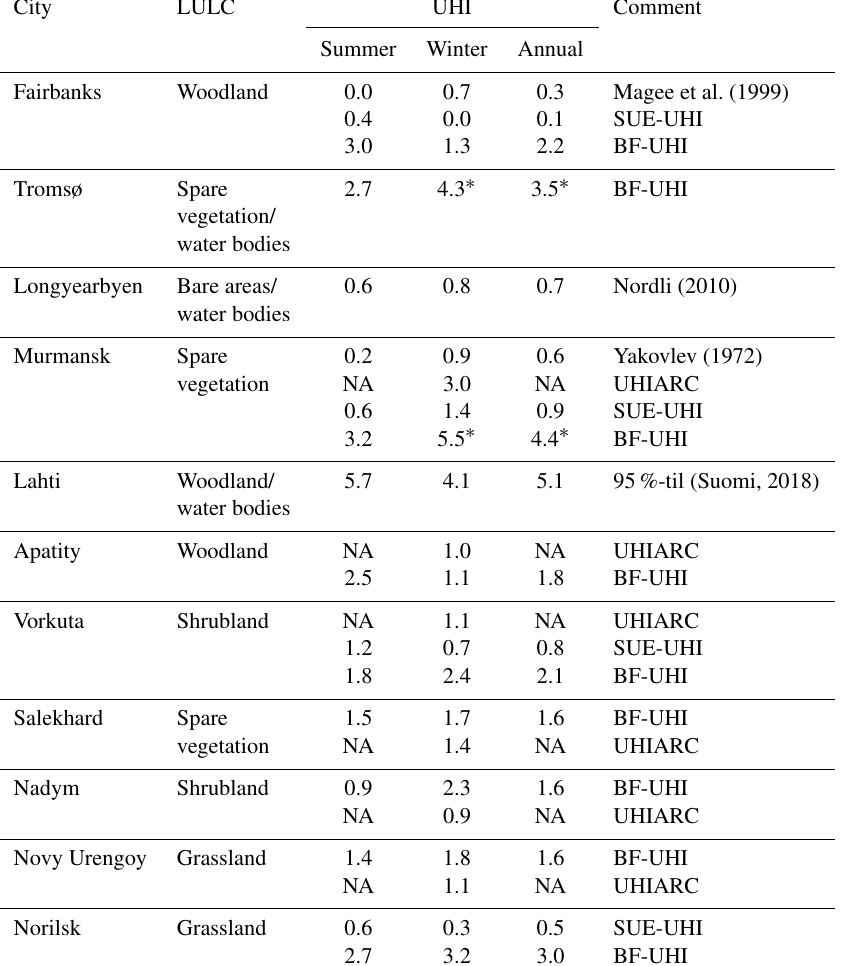
Table 1. The UHI intensity in several selected Arctic cities. Data from Esau et al. (2020) and Miles and Esau (2020) updated. NA stays not “Not Applied” specifying absence of data. LULC provides information about the dominant aggregated land use – land cover (LULC) type in the buffer zones following the classification of Esau and Miles (2018). The BF-UHI values are given for 2000–2016 period; other values are given as in the respective cited